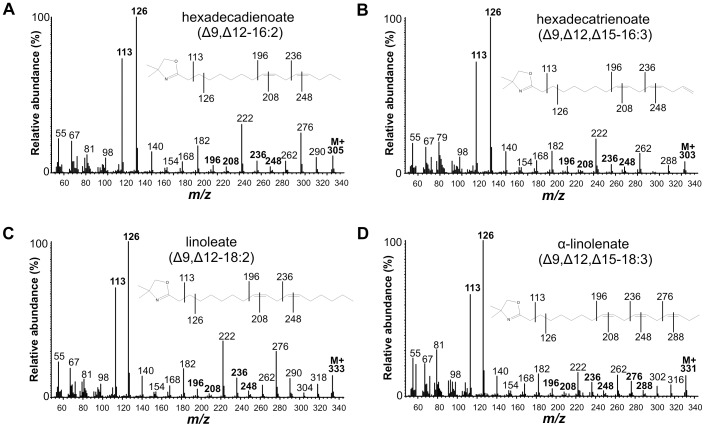
Mass spectra of DMOX derivatives of PUFAs detected in FAME extracts from CpFAD2 and CpFAD3 yeast strains.(A) Δ9,Δ12-16:2; (B) Δ9,Δ12,Δ15-16:3; (C) Δ9,Δ12-18:2; (D) Δ9,Δ12,Δ15-18:3. Characteristic fragments are highlighted and fragmentation patterns of DMOX derivatives are shown.